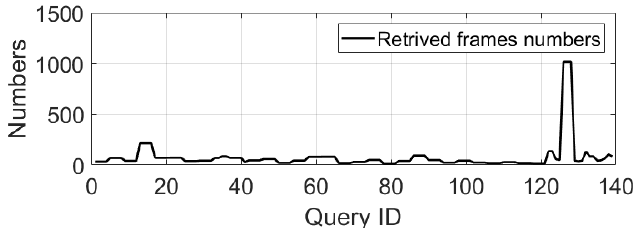
Figure 14. The number of retrieved video frames for each query image.